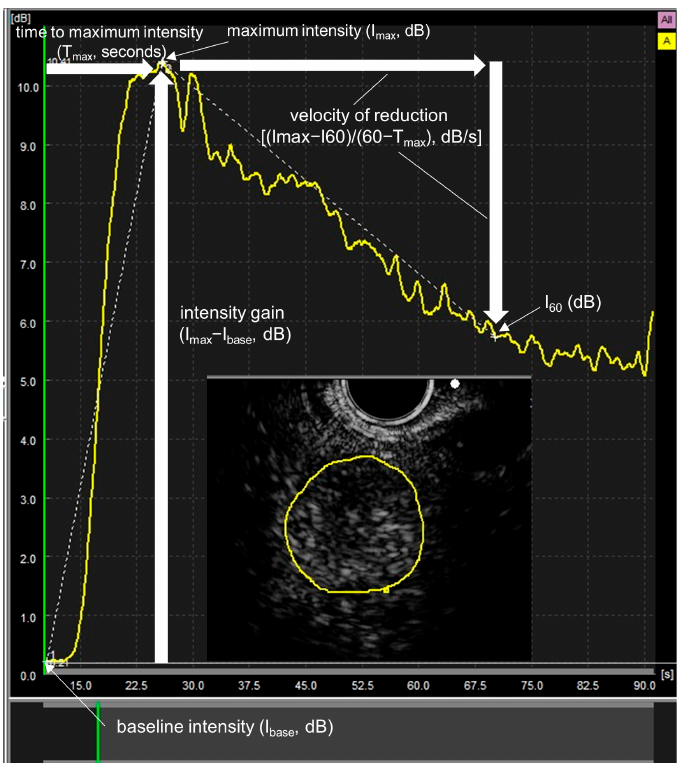
Figure 1. Quantitative evaluation using time–intensity curve (TIC) analysis for contrast enhanced endoscopic ultrasonography in malignant lymphoma. The region of interest is indicated by a yellow line. The following parameters were examined by TIC analysis. Baseline intensity (I base , dB)—echo intensity before contrast medium administration; I 60 —echo intensity at 60 s; maximum intensity (I max , dB)—maximum echo intensity from I base to I 60 ; time to maximum intensity (T max , s)—time to I max from I; intensity gain (I max − I base , dB)—intensity gain from I base to I max ; velocity of reduction ([I max − I 60 ]/[60 − T max ], dB/s)—velocity of reduction from I max to I 60 .